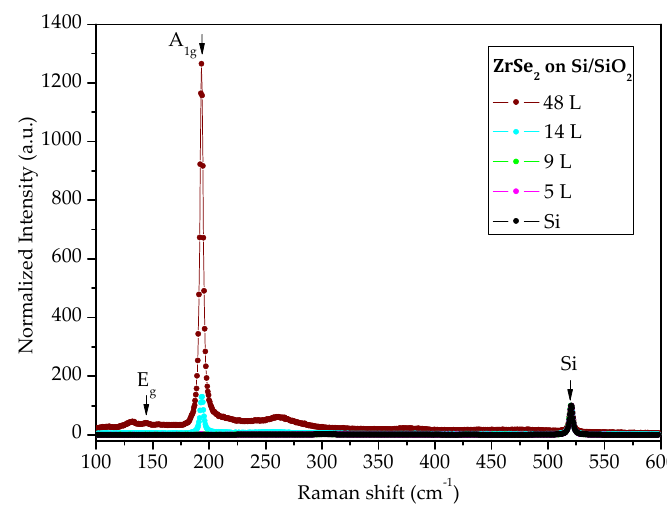
Figure C4. Thickness dependence of the Raman spectra for ZrSe 2 ( λ = 638 nm) on a silicon substrate with 285 nm of SiO 2 . The Raman modes A 1g and E g are labeled. Figure C5 corresponds to the bare spectra (in counts/s) for ZrSe 2 on a Si/SiO 2 substrate without